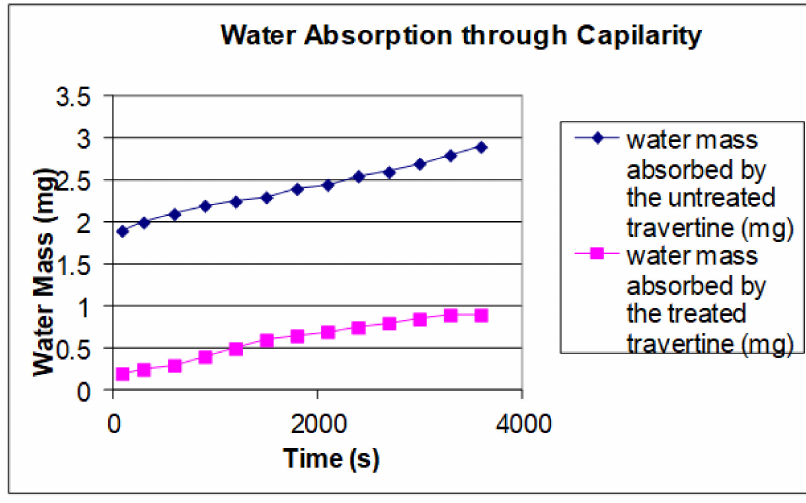
Figure 9. Water absorbed by the untreated and treated travertine within 1